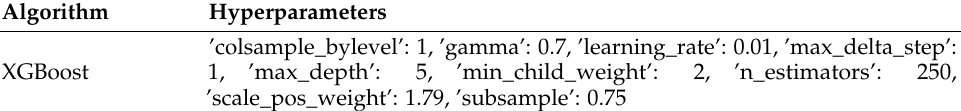
Table A2. Hyperparameters of XGBoost supervised classification machine learning model that predicts complete cytoreduction based only on the anatomic fingerprints referring to the EOC dissemination patterns.